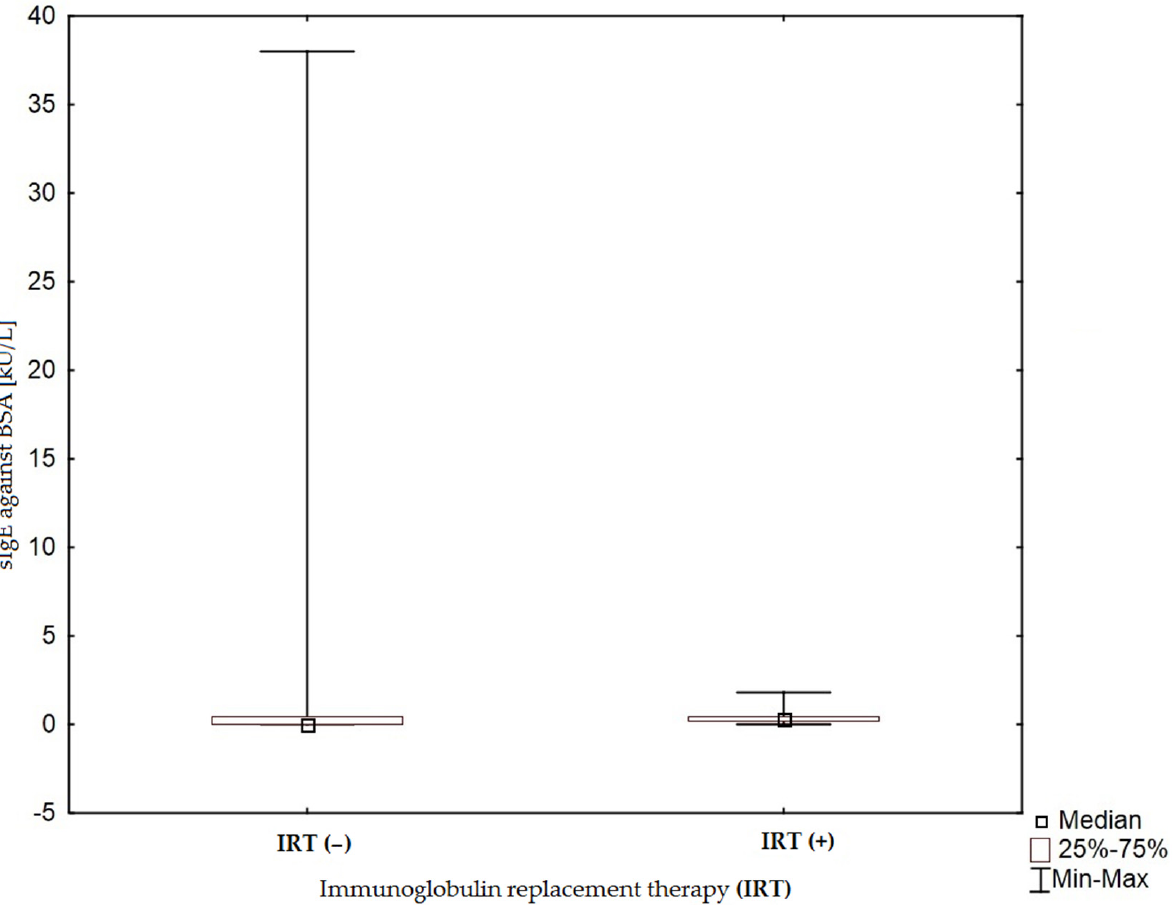
Figure 1. Concentration of sIgE against BSA (bovine serum albumin) in PID patients during immu ‐ noglobulin replacement therapy (IRT+) and not receiving IRT (IRT − ) ( p = 0.03).